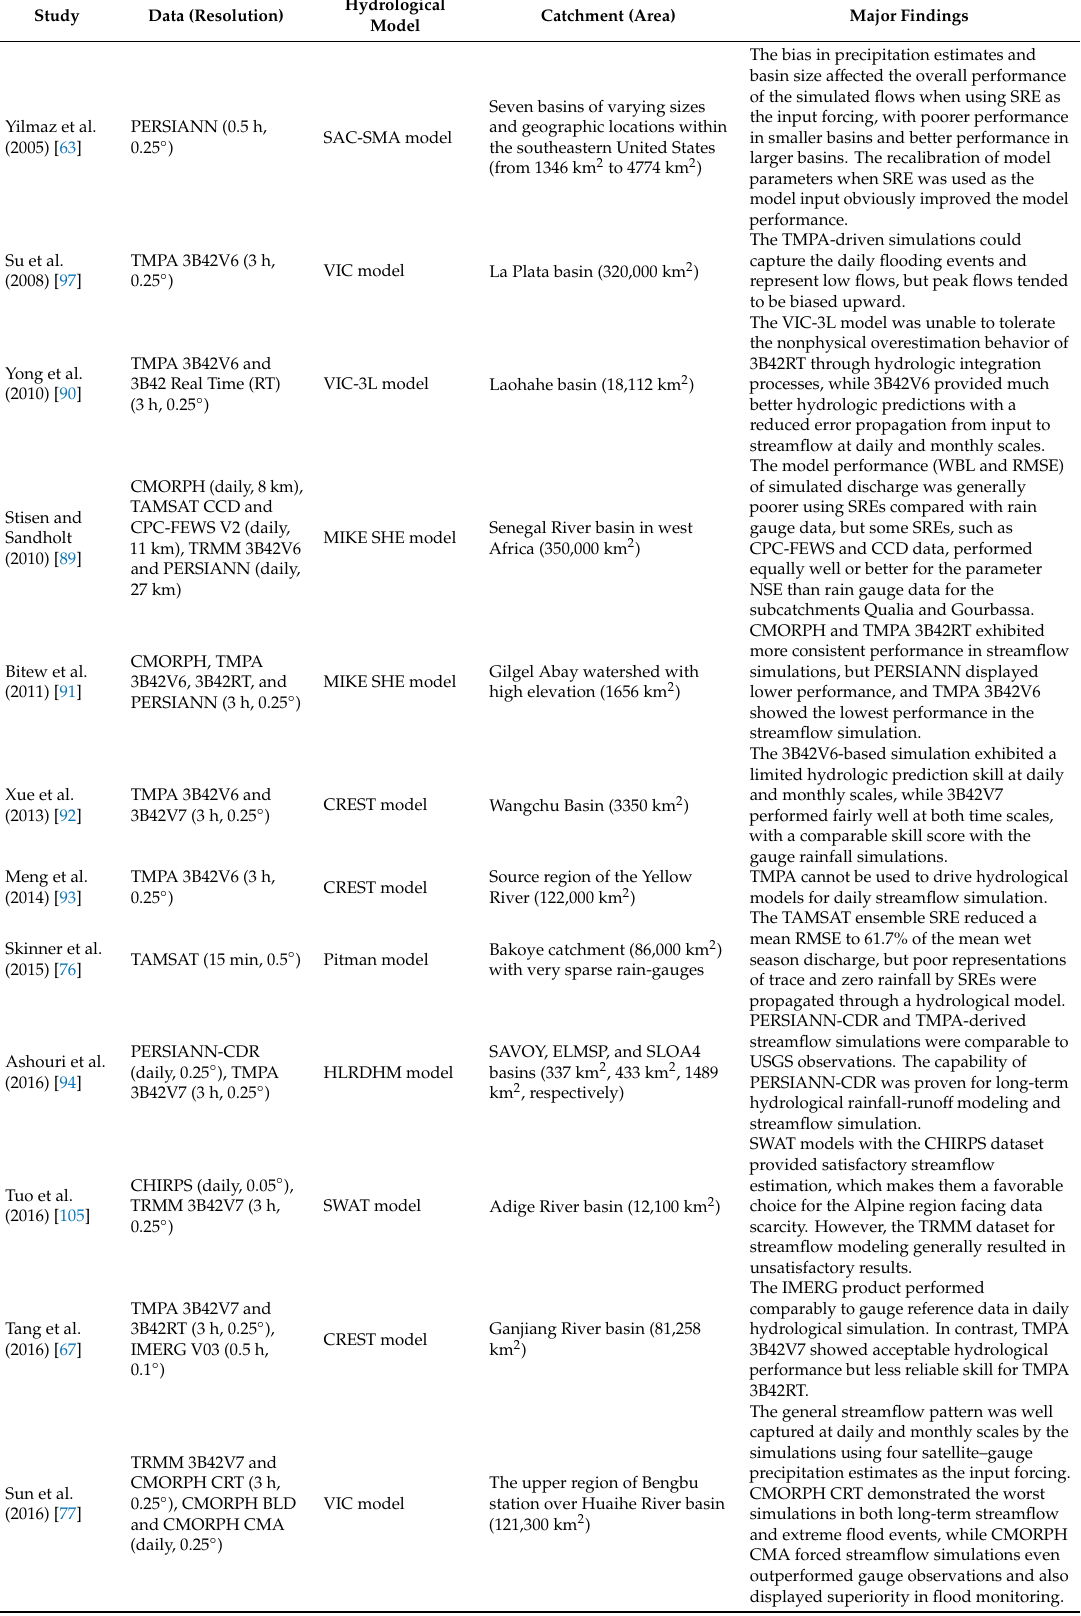
Table 1. Relevant studies using satellite-based precipitation products to drive hydrological